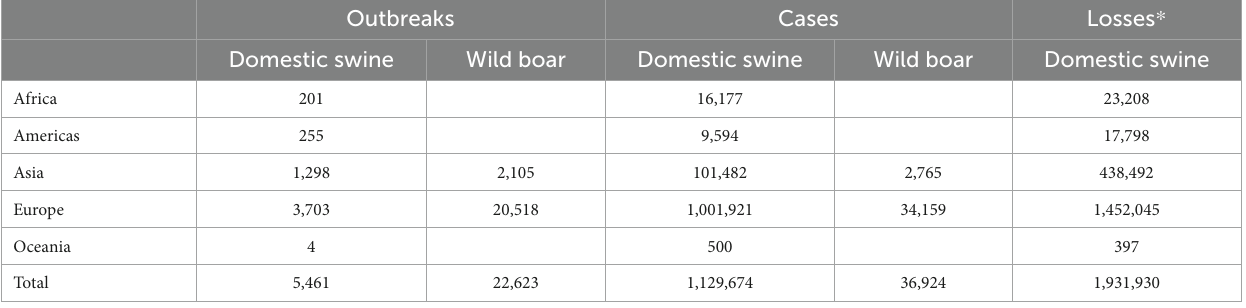
TABLE 1 Number of outbreaks, cases, and animal losses caused by ASF in different regions worldwide (2020, 01–2022, 09; Source: World Organization for Animal Health, World Health Organization, October 2022 line visit).